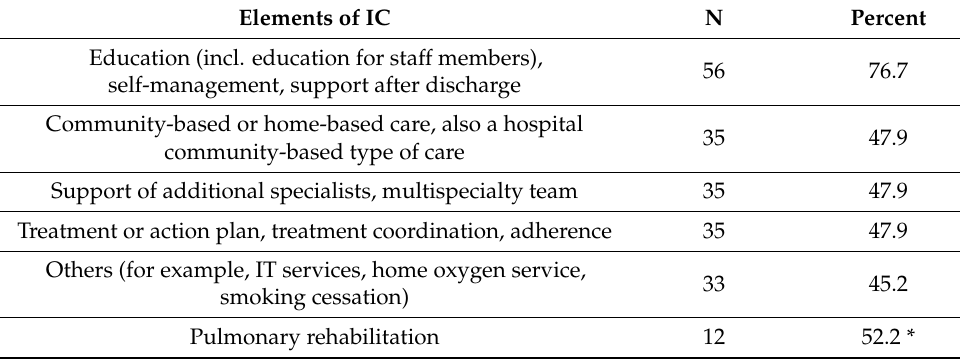
Table 1. Elements of integrated care.